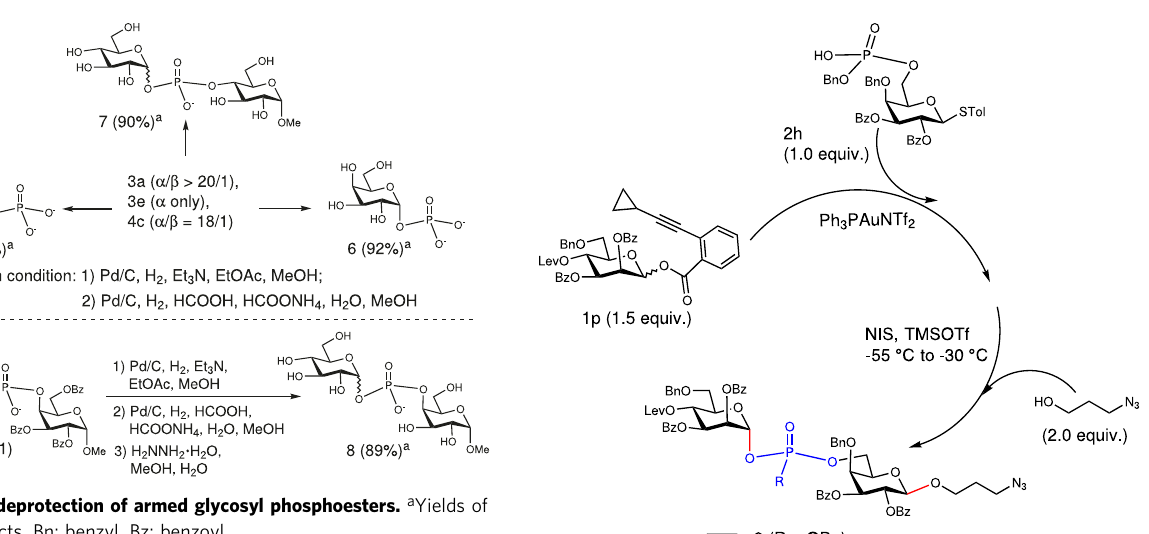
Fig. 5 The epimerization-glycosylation reactions with large glycosyl donors. a Yields of α / β mixtures ( α / β mixtures were not separable), and α / β ratios were determined by 31 P NMR. Bn: benzyl. Bz: benzoyl. In red are the formed glycosidic bonds. In blue are the acceptors of phosphoric acids and the phosphate moieties in the